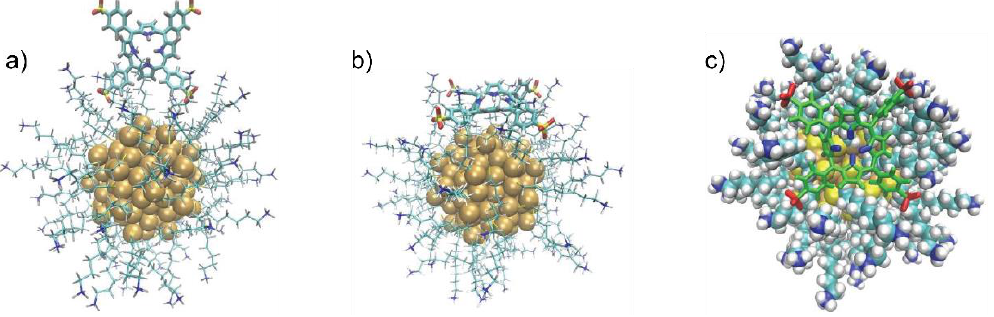
Figure 7. Significative representation of the nanocluster H 2 TPPS 2− supramolecular assembly. In ( a ), it is represented after 10 ns. ( b ) and ( c ) both depict the final conformation, after 1 μ s MD. A different representation is chosen in ( c ) to emphasize the formation of a bowl-like cavity in the ligand layer; SO 3 − peripheral groups and the pyrrolic protons are highlighted in red and blue, respectively.